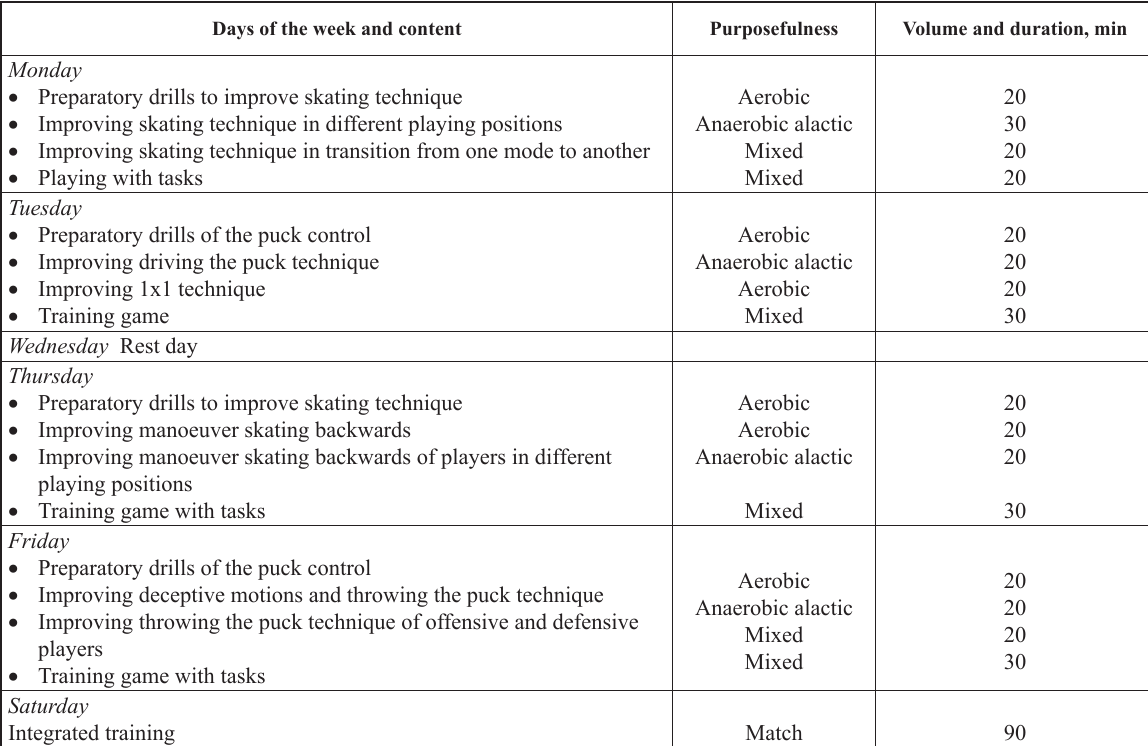
Table 2. Sample of micro-cycle weekly plan in the basic training period of the preparatory stage